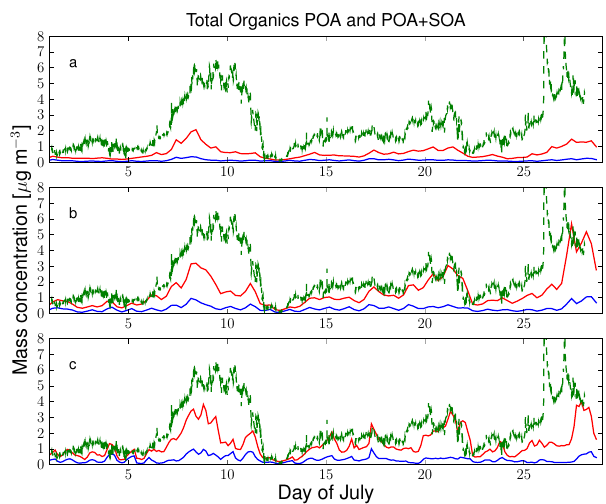
Fig. 4. Time series of organic aerosol concentrations for each sim- ulated resolution and measurements. Simulated POA is shown in blue, while the combination of SOA and POA (total OA) is shown in red. The measured organic concentrations are green. Panel (a) is 4 ◦ × 5 ◦ , (b) 2 ◦ × 2.5 ◦ and (c) 0.5 ◦ × 0.667 ◦ . The time is